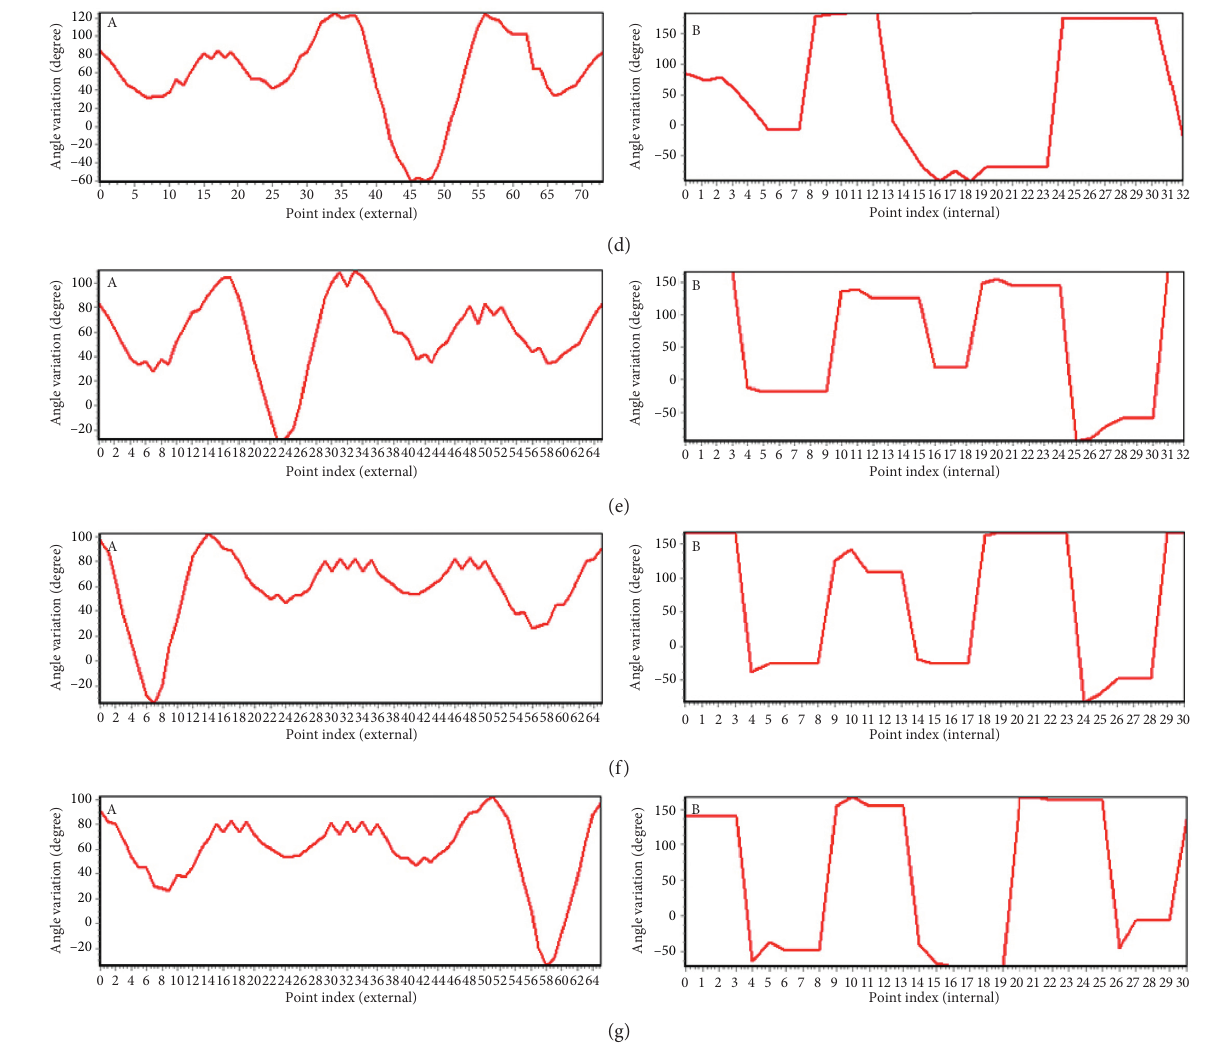
Figure 10: Angle variation of seven other elements. (a–g) Elements with labels 1–7.